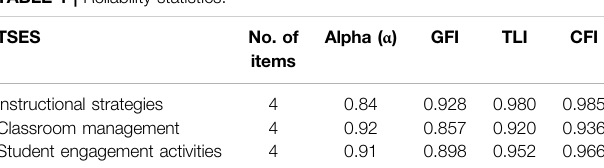
TABLE 1 | Reliability statistics. TSES No. of